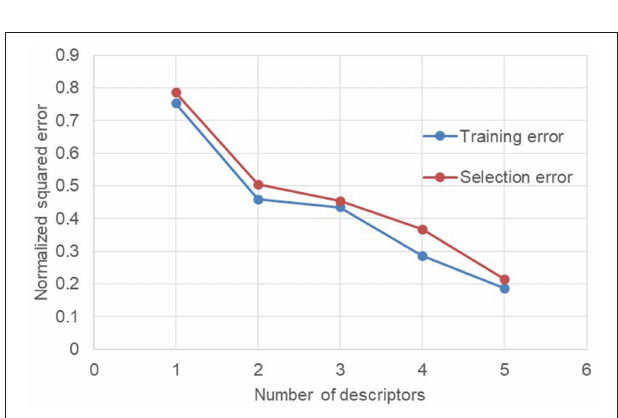
FIGURE 4 | Evolution of the normalized squared error depending of descriptors (without M n and – D) used for